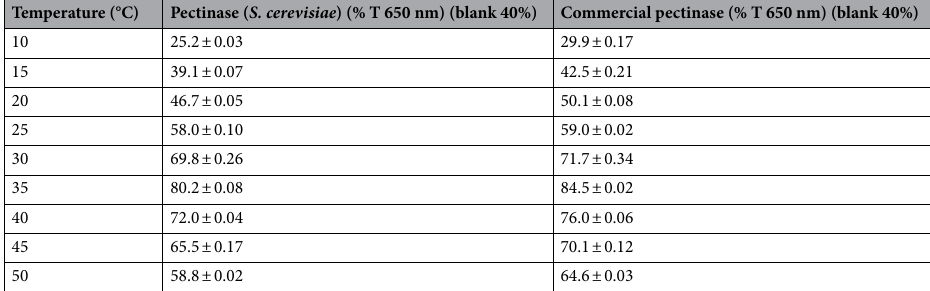
Table 2. Temperature effect on clarification of banana juice by pectinase of S. cerevisiae and standard commercial pectinase. Mean ± SE (n = 3); %T = % of transmission of light.